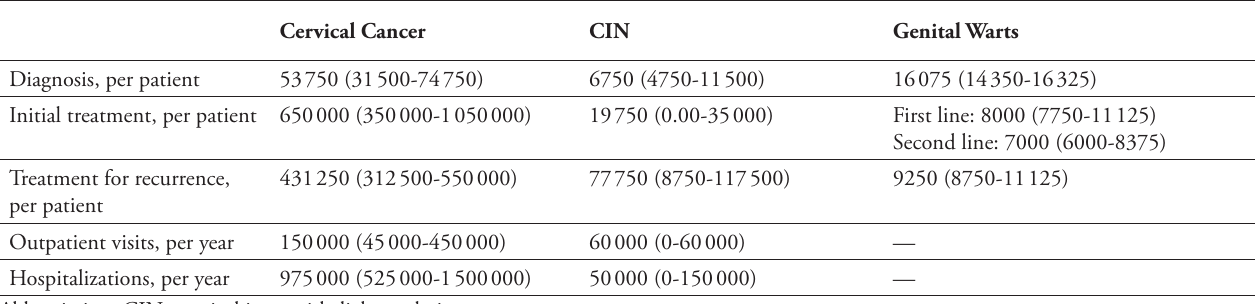
Abbreviation: CIN, cervical intraepithelial neoplasia. a Costs are reported as median (interquartile range) in DZD.